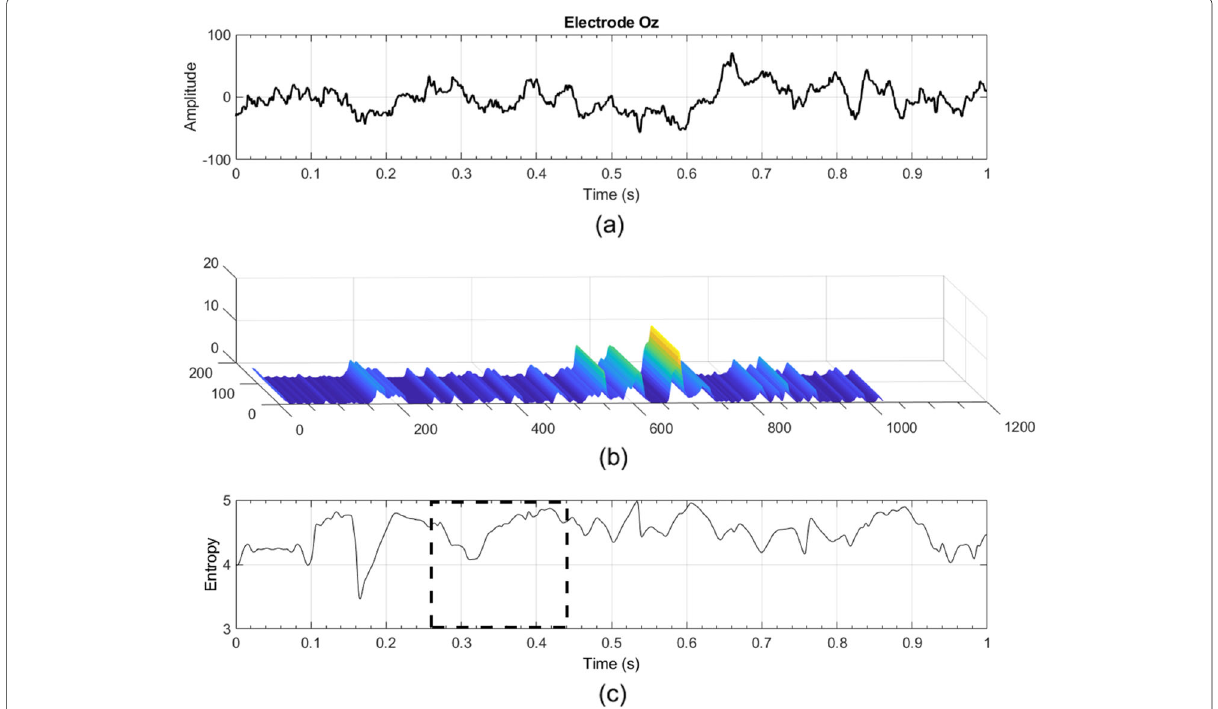
Fig. 19 Electrode Oz after RICI. a Time domain representation of ERP. b SPWVD time-frequency representation. c Short-term Rényi entropy of the distribution